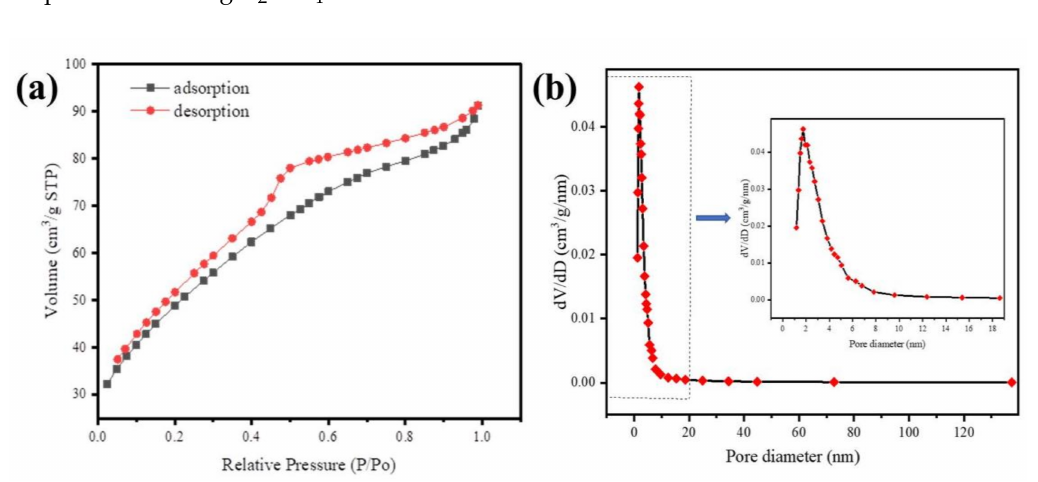
Figure 6. ( a ) N 2 adsorption-desorption isotherms of Fe@BC and ( b ) Barrett-Joyner-Halenda (BJH) curve (inset pore-size